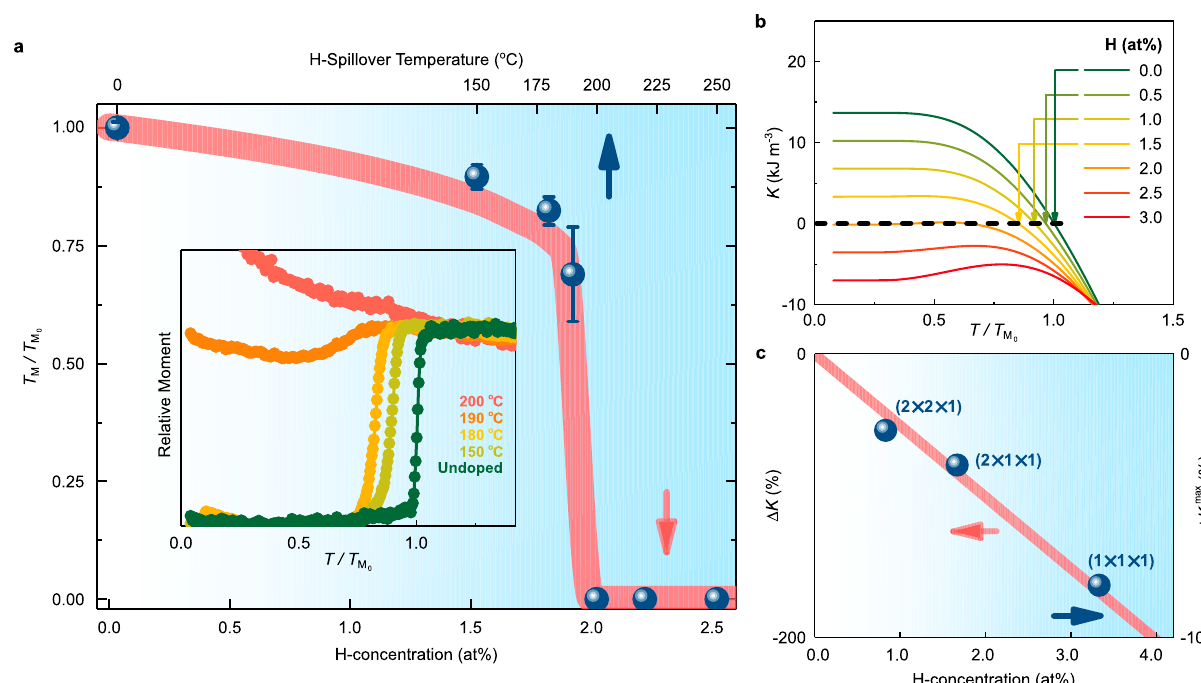
Fig. 2 Temperature and doping evolution of the Morin transition and overall magnetic anisotropy. a Evolution of the ratio of the Morin transitions after and before H-doping ( T M = T M ) in α -Fe 2 O 3 fi lms, as a function of the H-spillover temperature (upper abscissa), shown as blue spheres. Error bars represent 0 the width of the transition. H-spillover temperature is linked to the H-concentration (lower abscissa) from ERDA results (see Supplementary-S7). The blue shading increases with H-concentration. Inset shows the relative moment of some of the H annealed samples measured during temperature up-sweep in a measuring fi eld of 500 Oe (following cooling at 5000Oe). b Temperature-dependent trends of the total anisotropy at various fi xed values of H (at.%), i.e. at fi xed Fe 2 + -cation concentration, K ð x ¼ const ; T Þ , obtained from our phenomenological model. Positive and negative values of K stabilize out-of-plane and in-plane orientations, respectively. The Morin transition temperature as a function of doping, T plotted as the red line in the main panel of ( a ). c Evolution of the total anisotropy change as a function of H-doping at 0 K, Δ K x ; T ¼ 0 ð Þ , obtained as a percentage from the phenomenological model is given as the red line (left ordinate). The DFT calculated maximum value of the total anisotropy change, Δ K max ð x Þ , for H α -Fe i containing 2 O 3 cells of three sizes is represented as blue spheres (right DFT